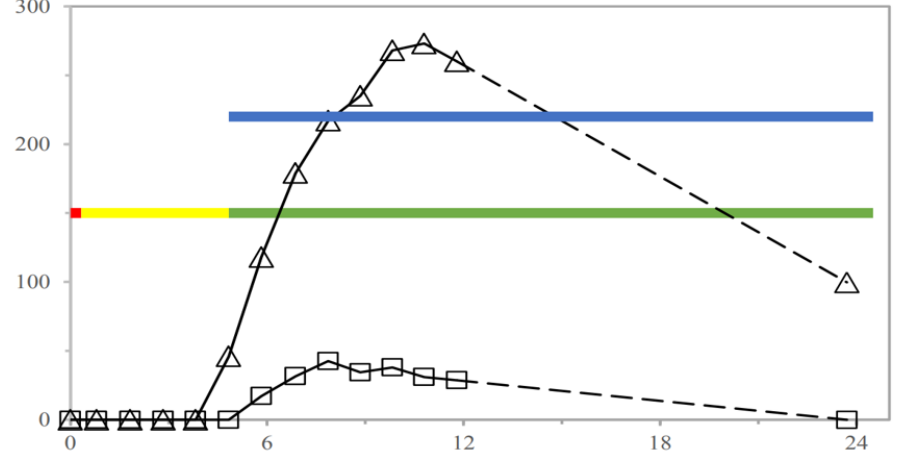
Figure 31. 5-ASA ( (cid:3) ) and N-acetyl 5-ASA ( ∆ ) plasma concentration profiles following administration of double-coated Chronotopic ® systems (Methocel ® E50 applied to 50% weight gain) to one fasted volunteer (subject #2). The dashed portion of the curves indicates the 12–24 h time frame during which